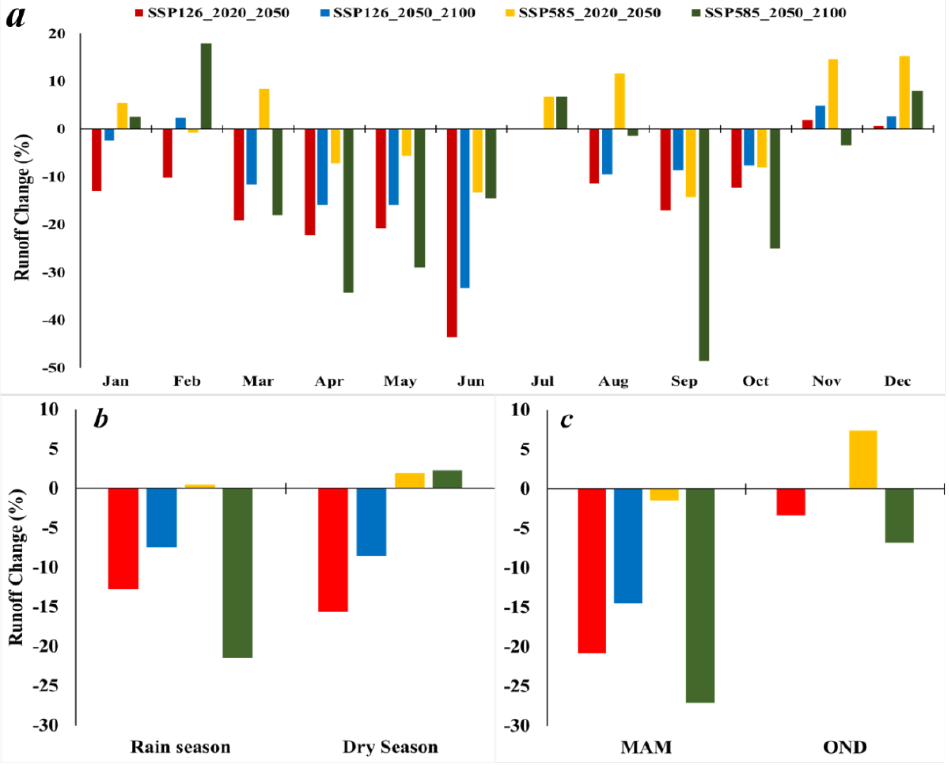
Figure 8. Relative runoff changes: ( a ) monthly, ( b ) seasonal, and ( c ) in rainy seasons.